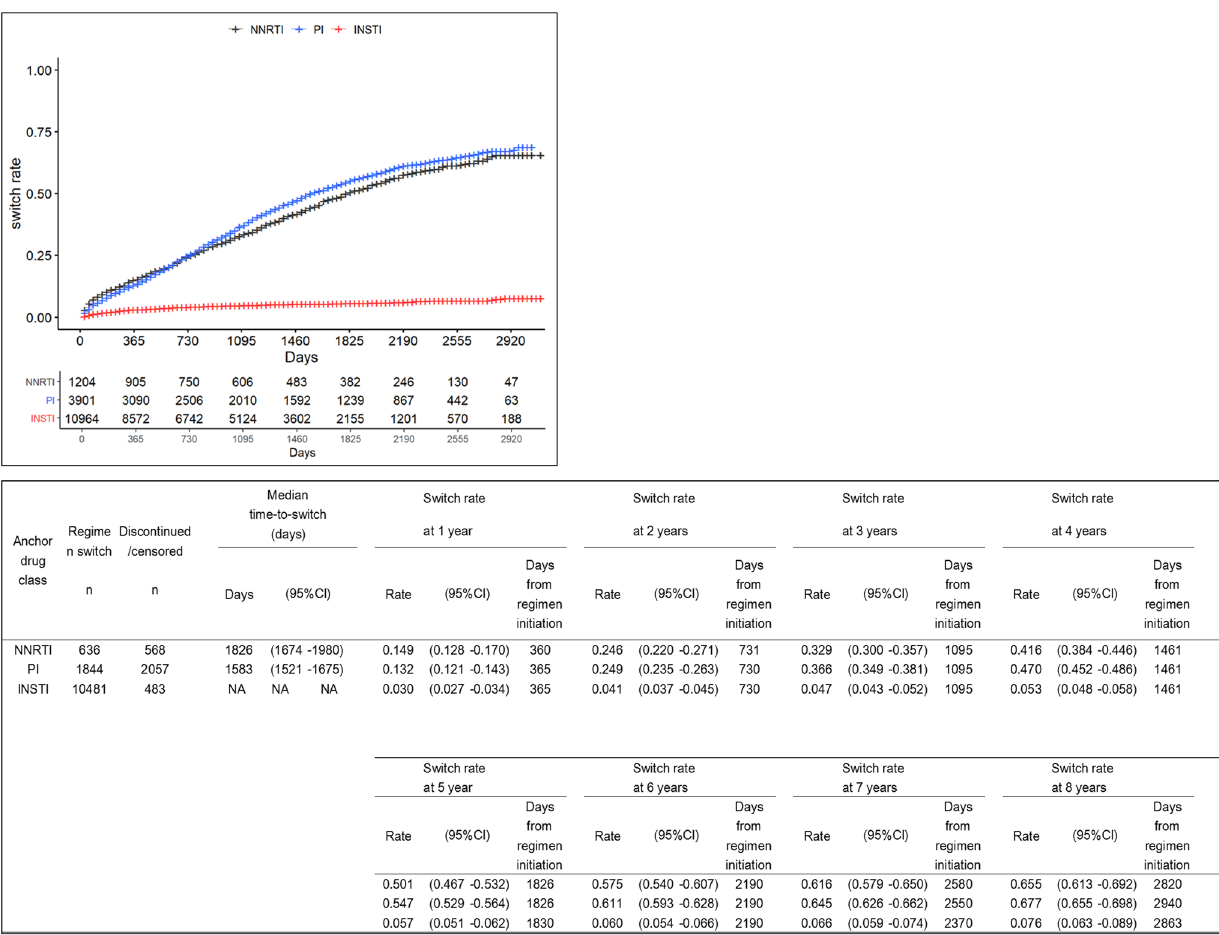
Figure 2. Time-to-switch of ART regimens according to anchor drug class from 2011 to 2019. The median time-to-switch and switch rates of anchor drug classes were estimated by Kaplan–Meier analysis. Brookmeyer– Crowley and Greenwood methods were used to estimate 95% confidence intervals for switch rates and median days, respectively. ART Antiretroviral therapy, NNRTI Non-nucleoside reverse transcriptase inhibitor, PI Protease inhibitor, INSTI Integrase strand transfer inhibitor, EI Entry inhibitor, CI Confidence interval. EI was excluded from the table as only one patient was prescribed EI